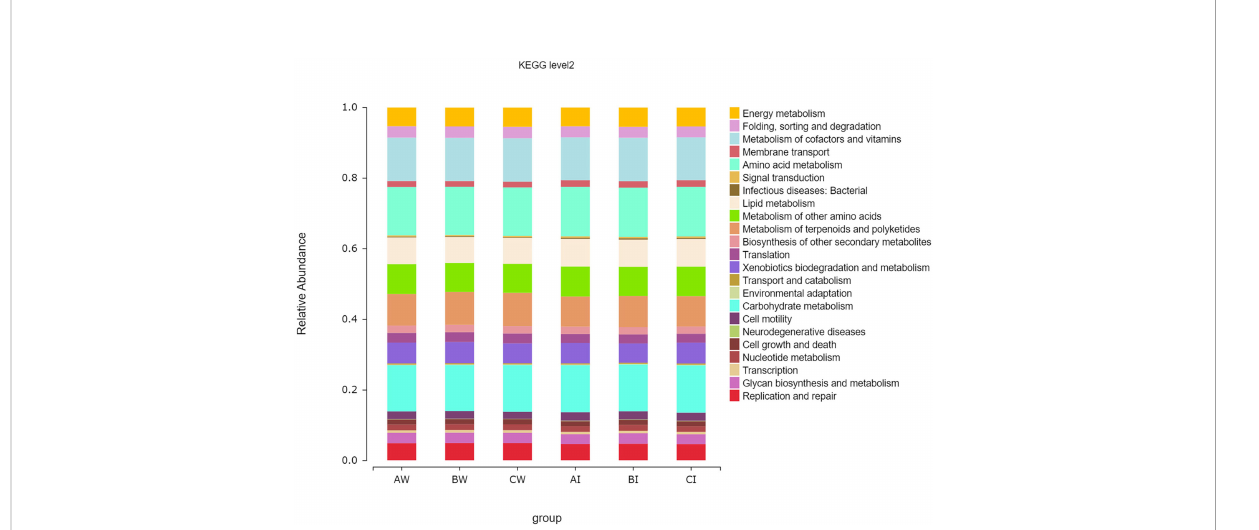
FIGURE 7 Effect of sodium humate (BW, BI) and sodium humate with probiotics (CW, CI) on KEGG function classi fi cation of microbiota in culture water and intestine in the three